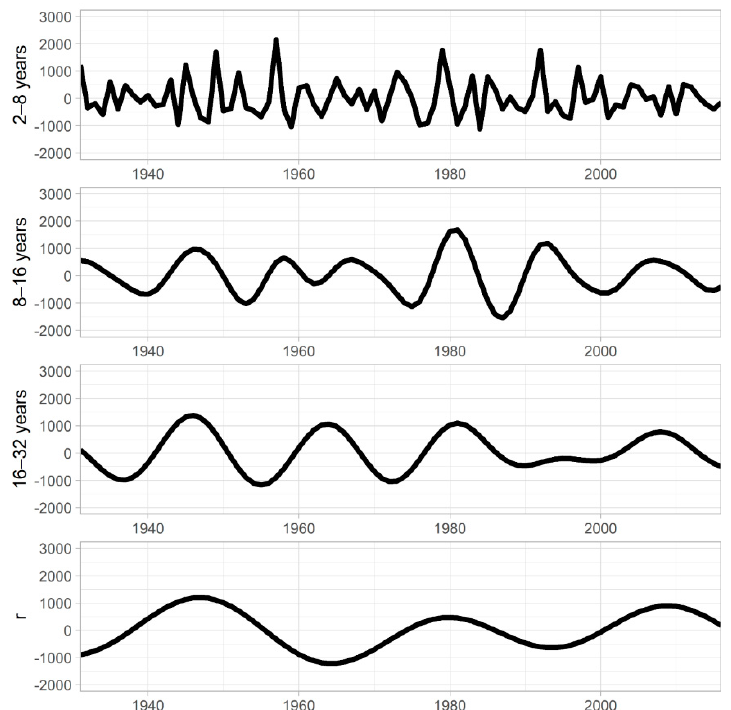
Figure 4. The reconstructed time series of the wavelet transforms decomposition. The y-axis represents the different frequencies selected for a band-pass filter of wavelets for the reconstruction of the time series. The first series is the high-frequency (2–8 years), next is the medium-frequency (8–16 years), followed by the low-frequency (16–32 years) and the residue, which is the frequency higher than 32 years.